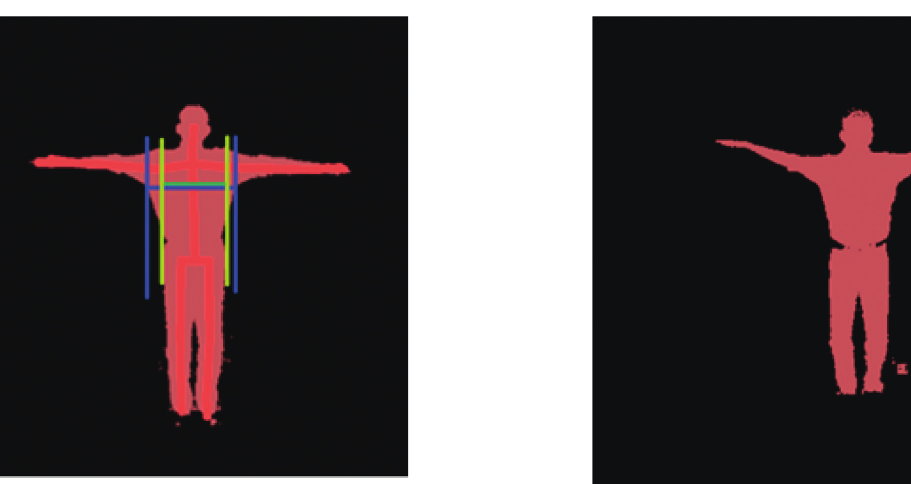
Figure 12: The person wearing too baggy shirt and trousers.